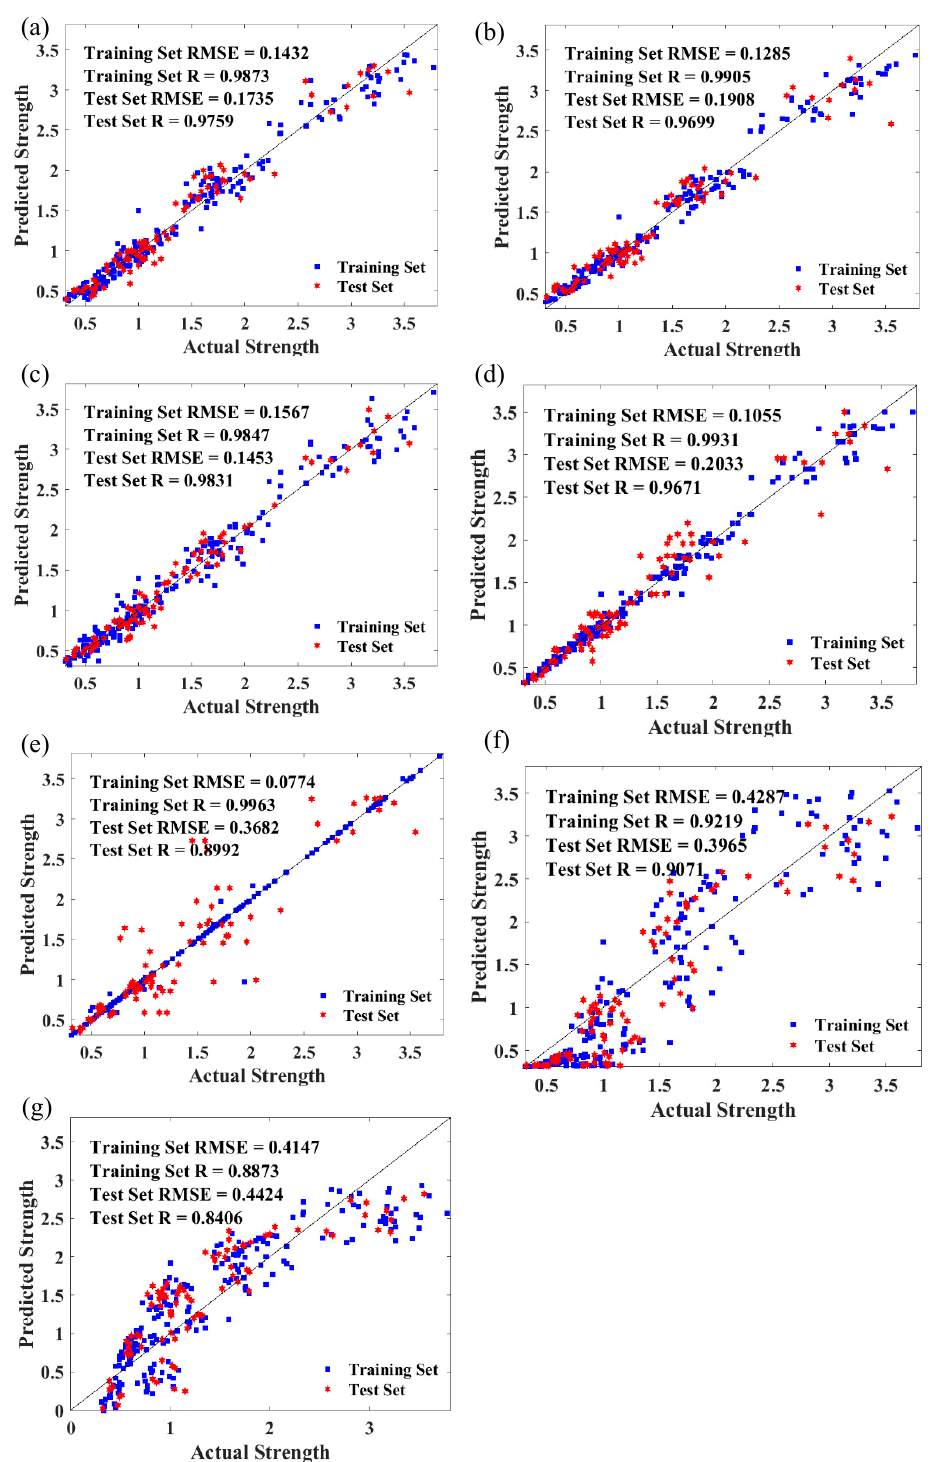
Figure 6. Comparison of different models: ( a ) support vector machine (SVM); ( b ) random forest (RF); ( c ) back-propagation (BP); ( d ) decision tree (DT); ( e ) k-nearest neighbors (KNN); ( f ) logistic regression (LR); and ( g ) mixed logistic regression (MLR).